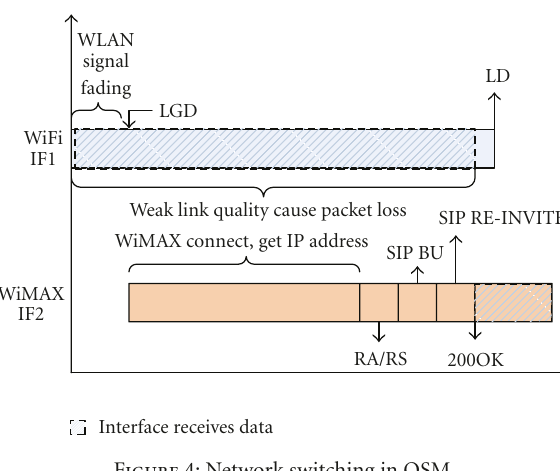
Figure 4: Network switching in OSM.